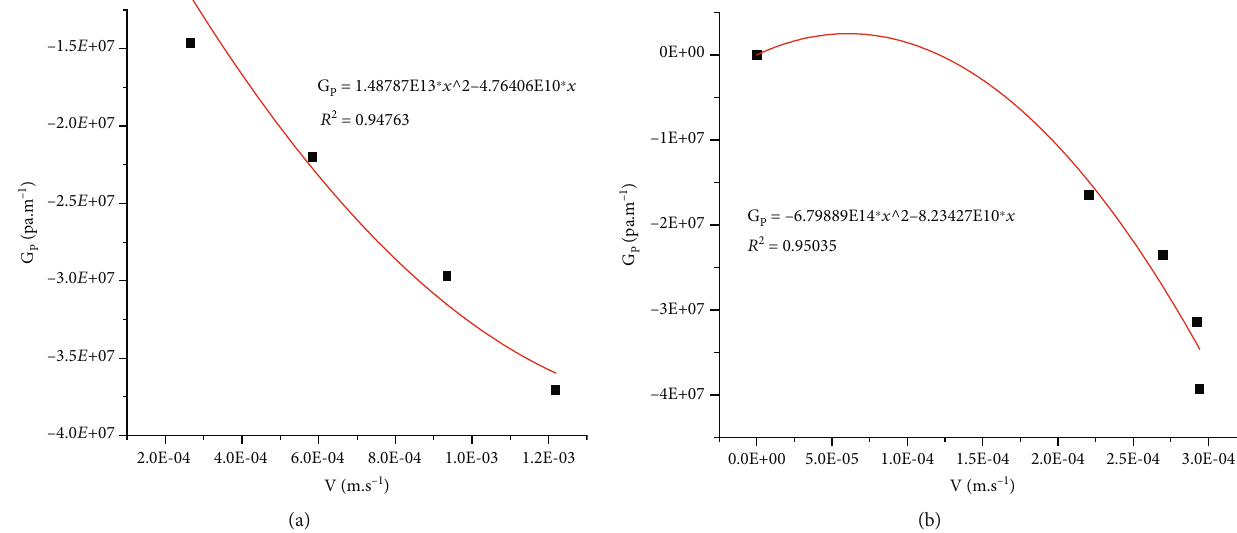
V of the fi lling gangues with a particle size of 10 ~ 15 mm at di ff erent axial loads: (a) 6MPa and Figure 9: Fitted curves between G p and (b)